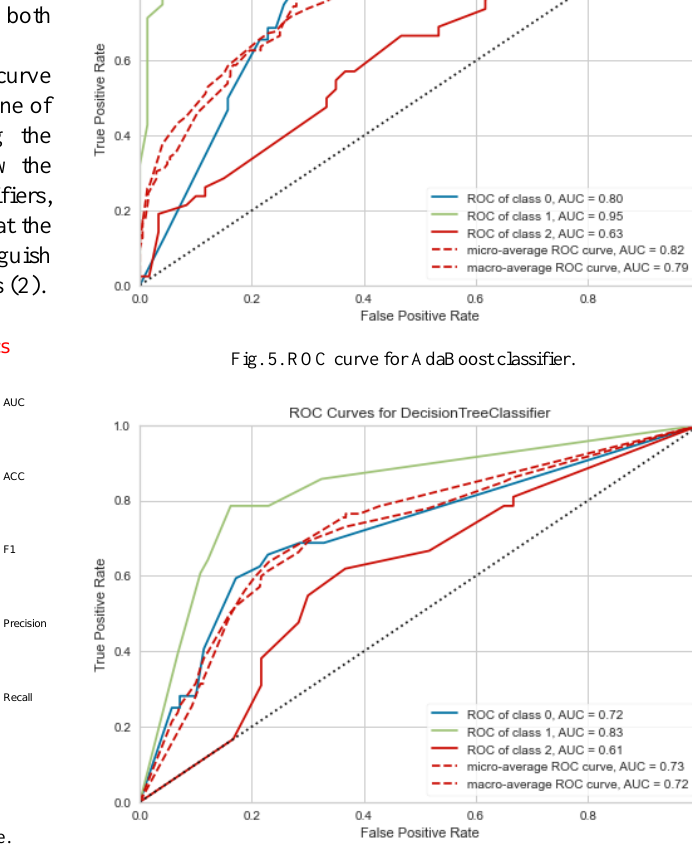
Fig. 6. ROC curve for DT